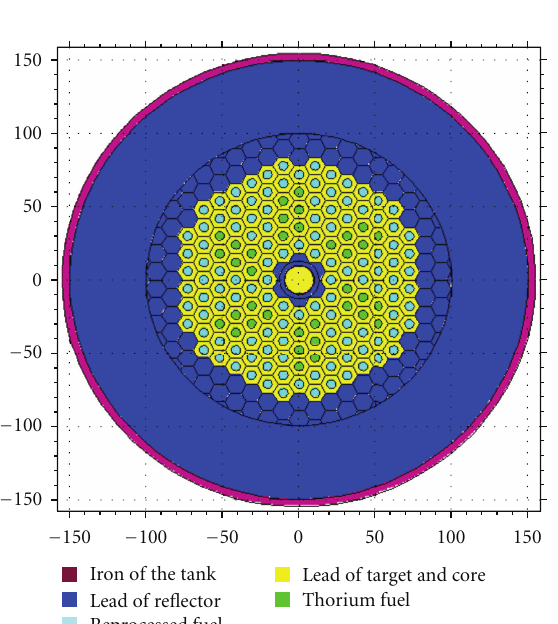
Figure 1: Horizontal cross section of the ADS simulated.